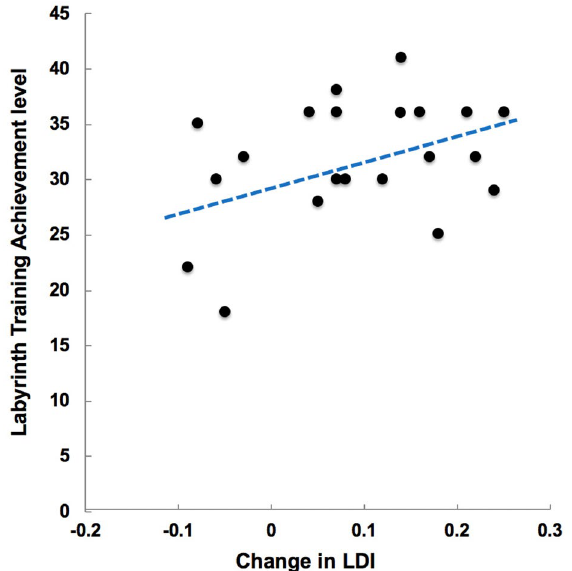
Figure 4. Individual Differences. Relative to their game achievement level, individual change scores in LDI (i.e., T2-T1) are presented for participants in the Labyrinth-VR treatment arm. A trend was evident between higher Labyrinth achievement and treatment-induced gain in LDI ( p = 0.10).